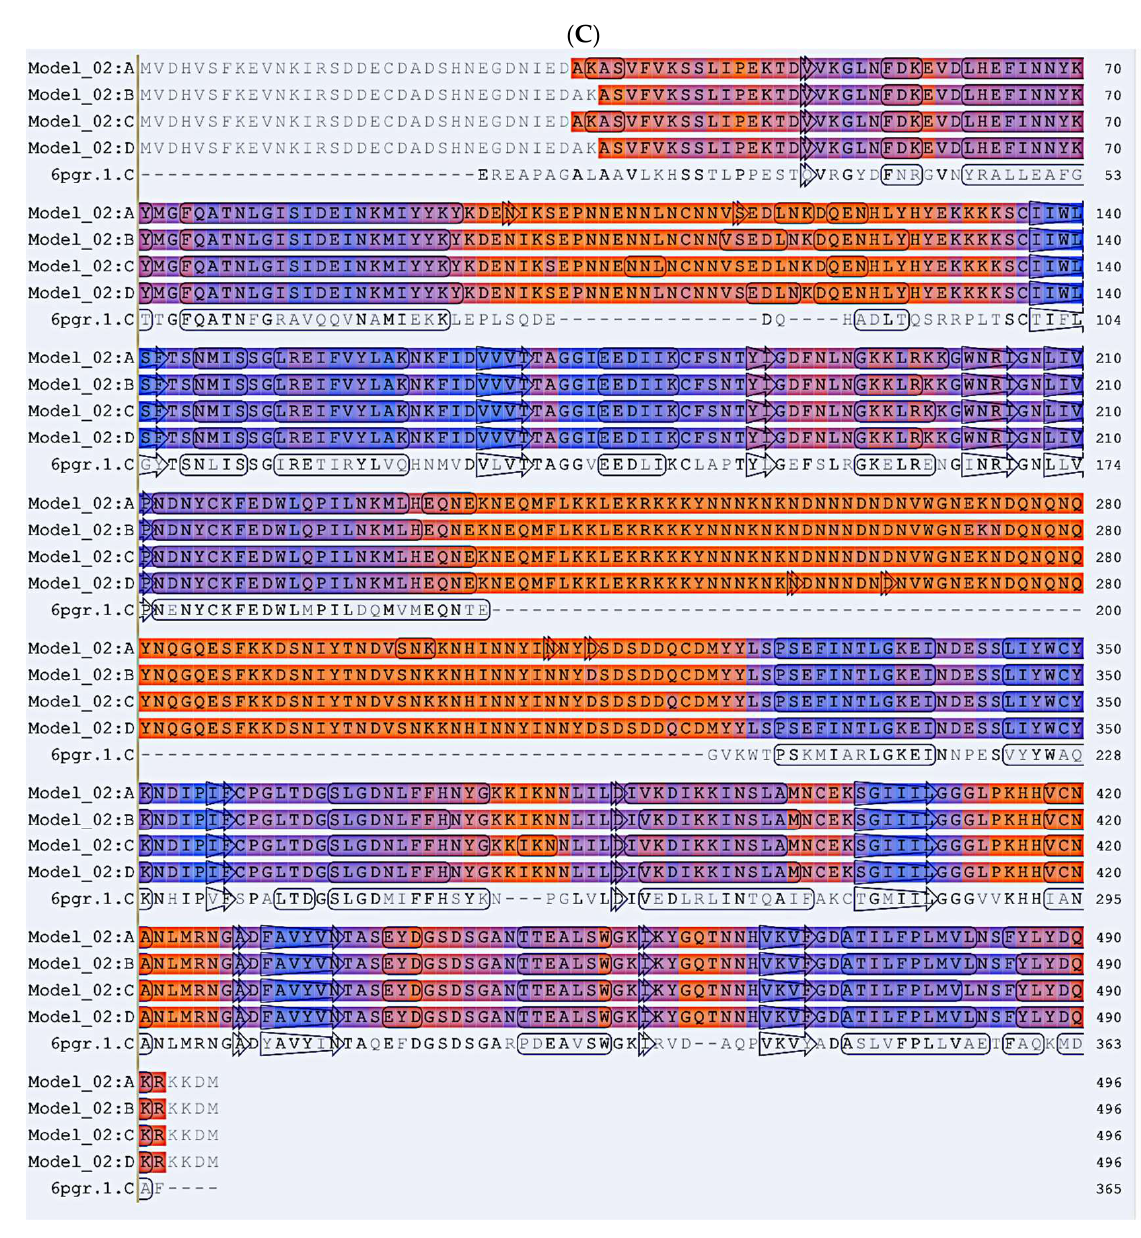
Figure 6. ( A ) In silico homology model of Pf DHS. Modelling was performed on the template alignment of human DHS co-crystallized with 6-bromo- N -(1 H -indol-4yl)-1-benzothiophene-2- carboxamide (PDB 6pgr) and Pf DHS (PDB 1rlz.1A) generated by Swiss Model. The protein consists of four identical subunits shown in rainbow, i.e., red (subunit A), blue (subunit B), green (subunit C) and brown (subunit D). ( B ) Graph of local quality estimate for the homology model structure of Pf DHS. Q-MEAN score (y-axis) is plotted against Pf DHS residue number. Subunits of a putative tetramer are plotted on the same axes (Chain A: grey; Chain B: yellow; Chain C: cyan; Chain D: green). ( C ) Alignment of P. falciparum DHS strain D7 (PDB:1rlz.1A) and human DHS co-crystallized with 6-bromo- N -(1 H -indol-4yl)-1-benzothiophene-2-carboxamide (PDB: 6pgr). Secondary structure elements are indicated on the protein residues (oblong, alpha helix; arrow, beta-sheet).